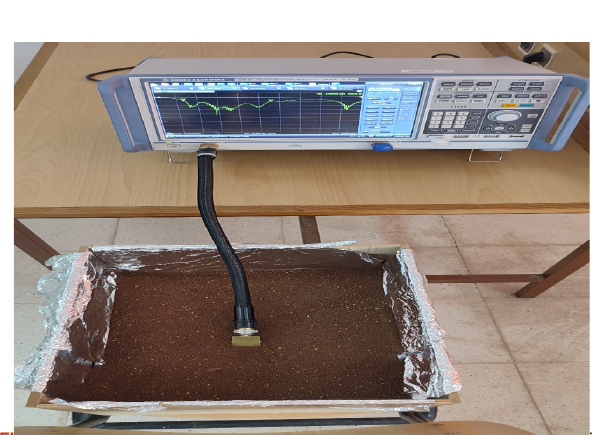
FIGURE 15. S 11 measurements of the fabricated antenna, (a) in an anechoic chamber, (b) in contact condition with the sandy soil box.